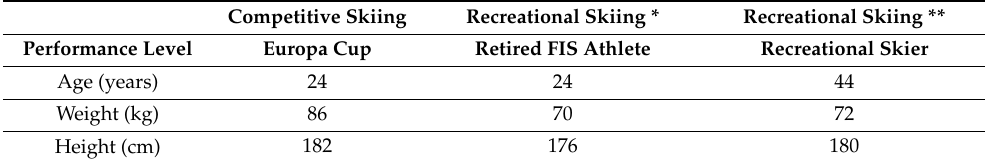
Table 1. Descriptive data of the participants in the study. Nomenclature: kilograms (kg) and centimeters